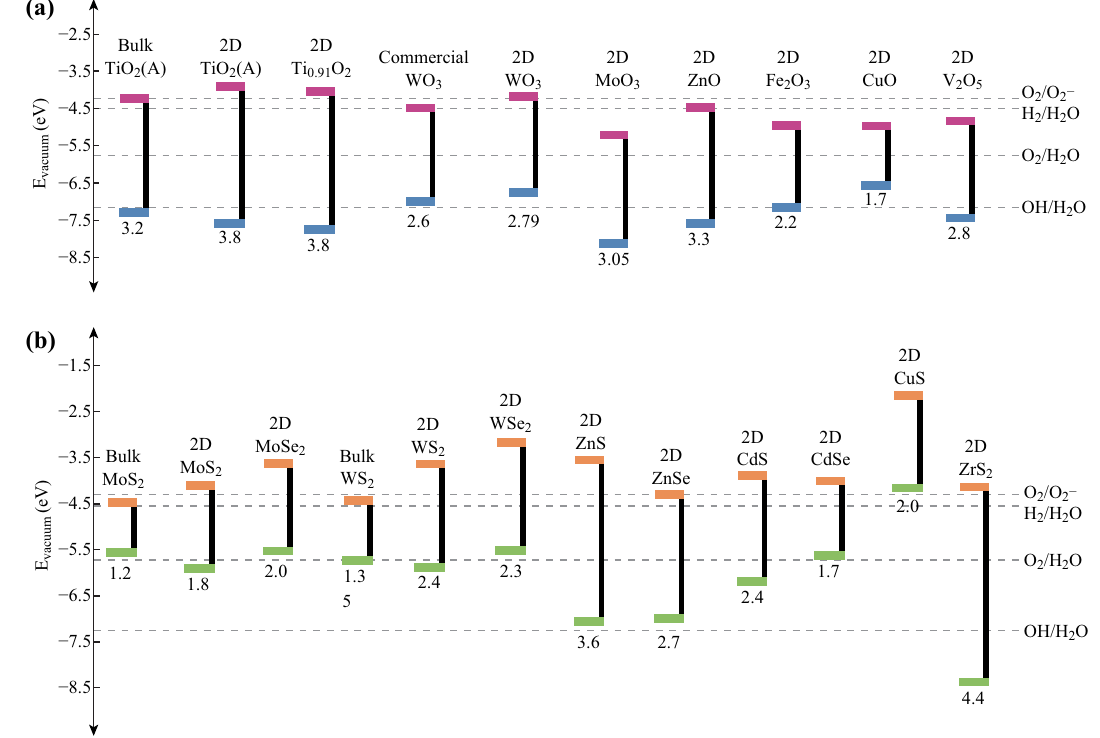
Fig. 1 Band structure of currently popular a transition metal oxides and b transition metal chalcogenides for photocatalytic applications [35, 103, 104,